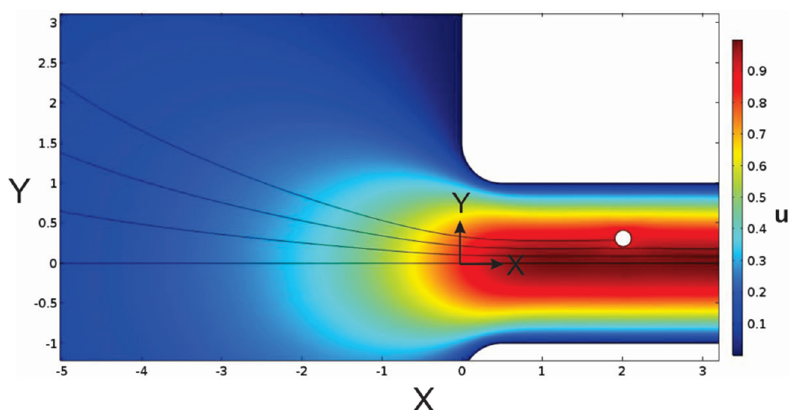
Figure 2 . Velocity profile of fluid and particle trajectories for particles with λ = 0.1 and specific gravity = 1.1, initially placed in the reservoir at X initial = − 5 and Y initial = 0, 0.6, 1.4 and 2.2. For these simulations, r c = h /2.